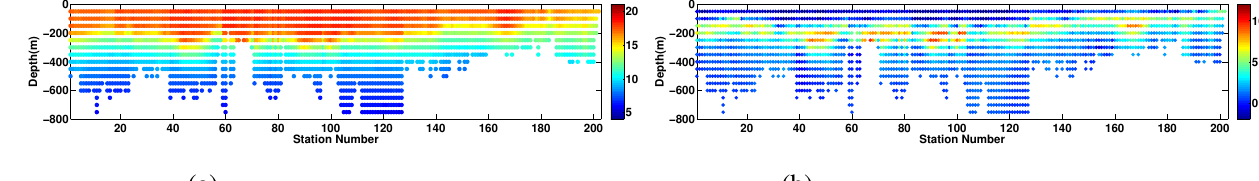
30 November 2008 is shown here.